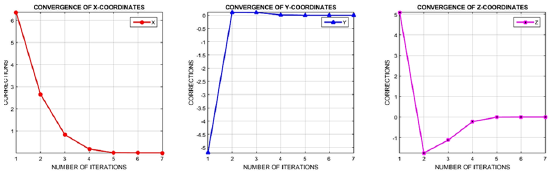
Figure 7. Convergence of pose corrections of the simulated panoramic image to zero